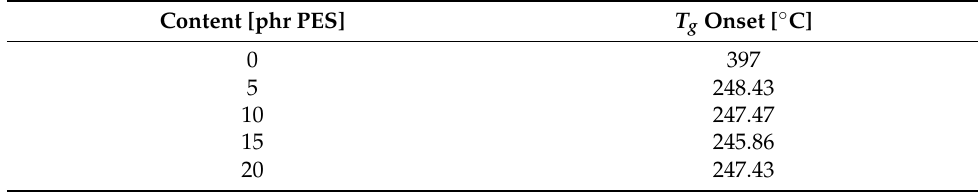
Figure 4. Storage modulus measured via dynamic measurements. Table 1. Effect of different PES content on the T g onset of the polymer blend.